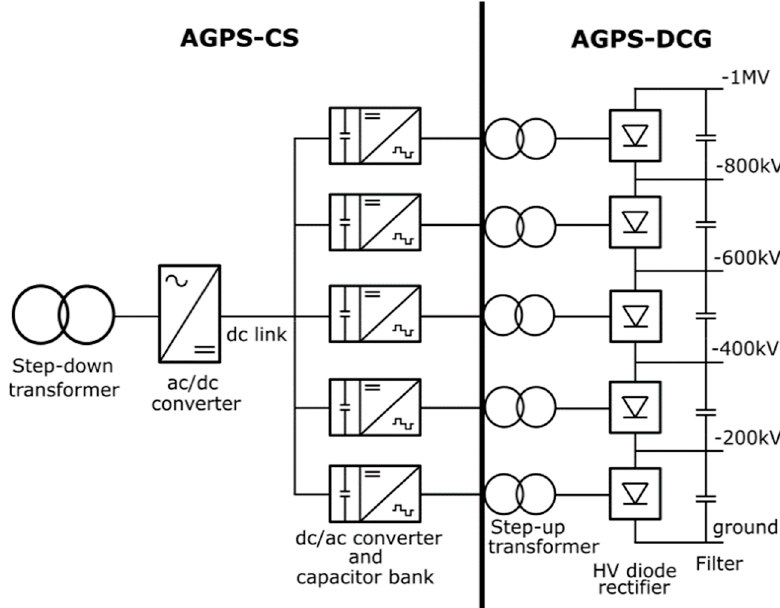
Figure 1. AGPS electrical scheme.